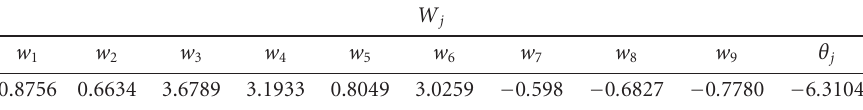
Table 13: The weights corresponding to the hidden layer and output layer.